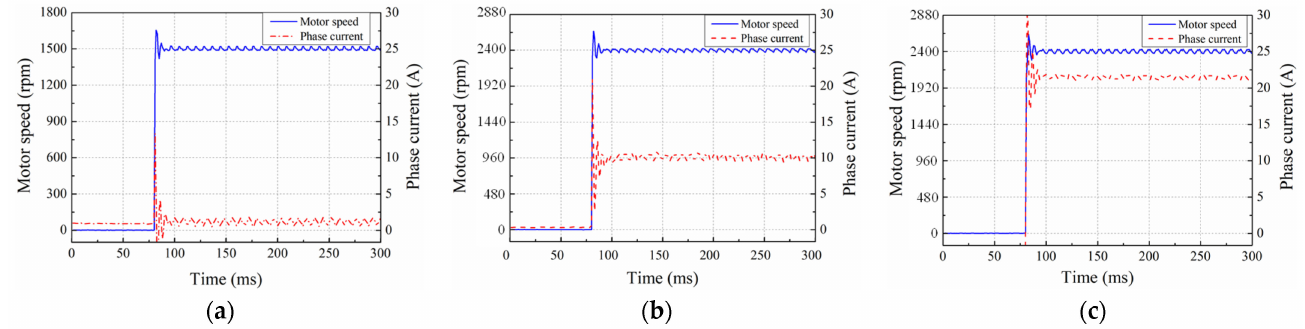
Figure 7. Dynamic response and phase current of FSPM. ( a ) No-load condition; ( b ) 30 N · m load condition; ( c ) 65 N · m load